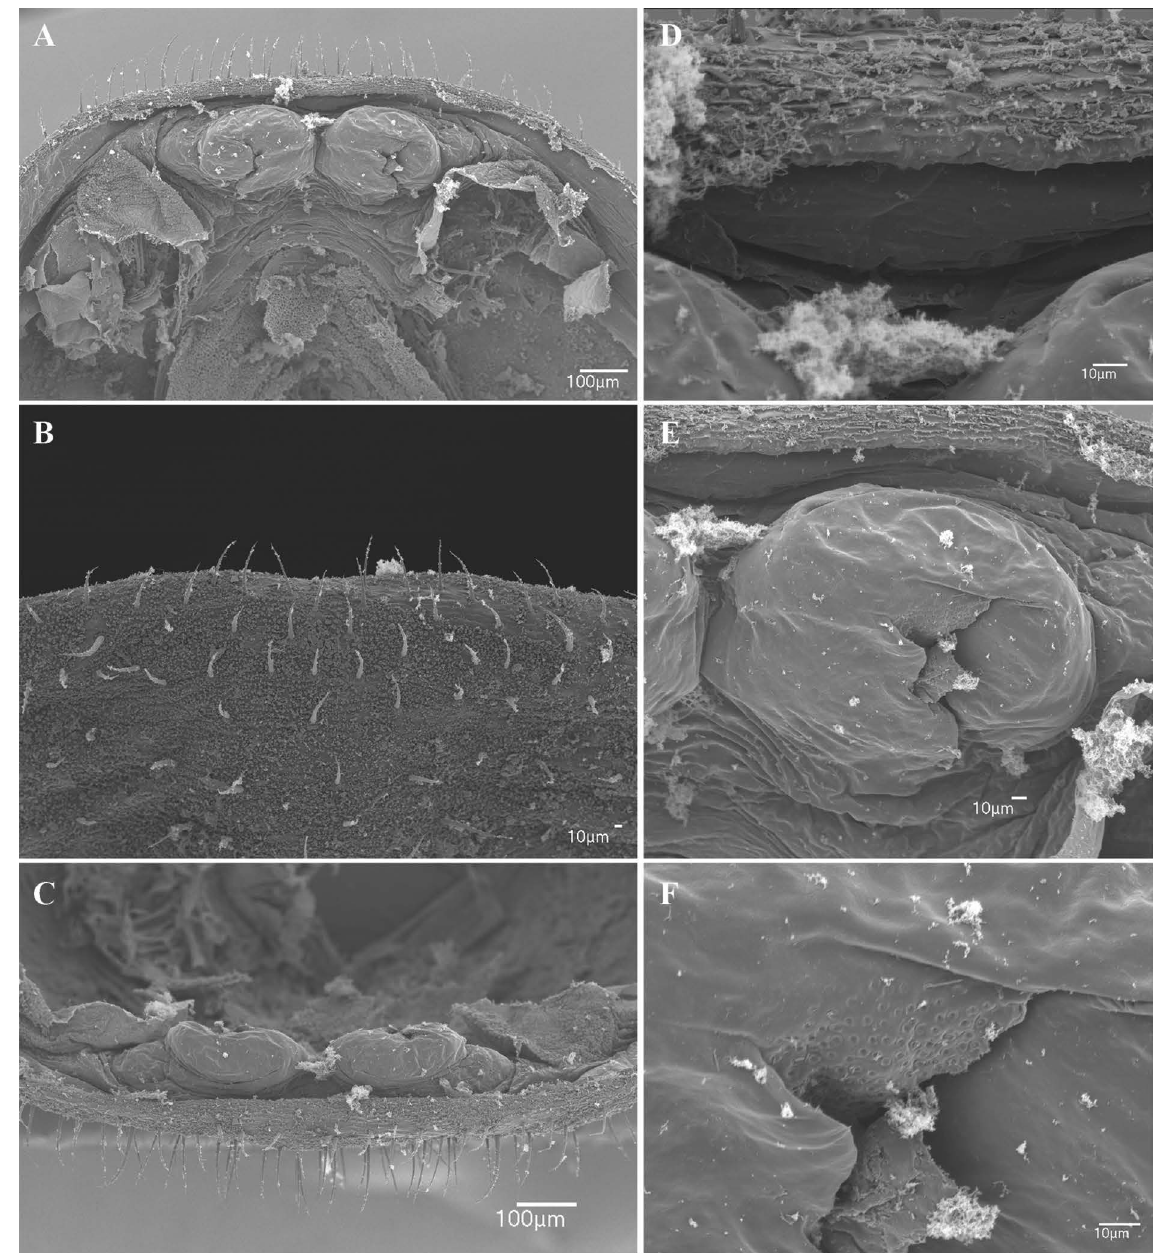
Fig. 70. Charinus monasticus sp. nov. (MNRJ 9103), female gonopod and genital operculum. A . Cushion- like gonopod, dorsal view. B . Posterior margin of genital operculum, ventral view. C . Gonopods, posterior view. D . Genital operculum between gonopods. E . Dextral gonopod and gonopore. F . Glandular openings inside gonopod